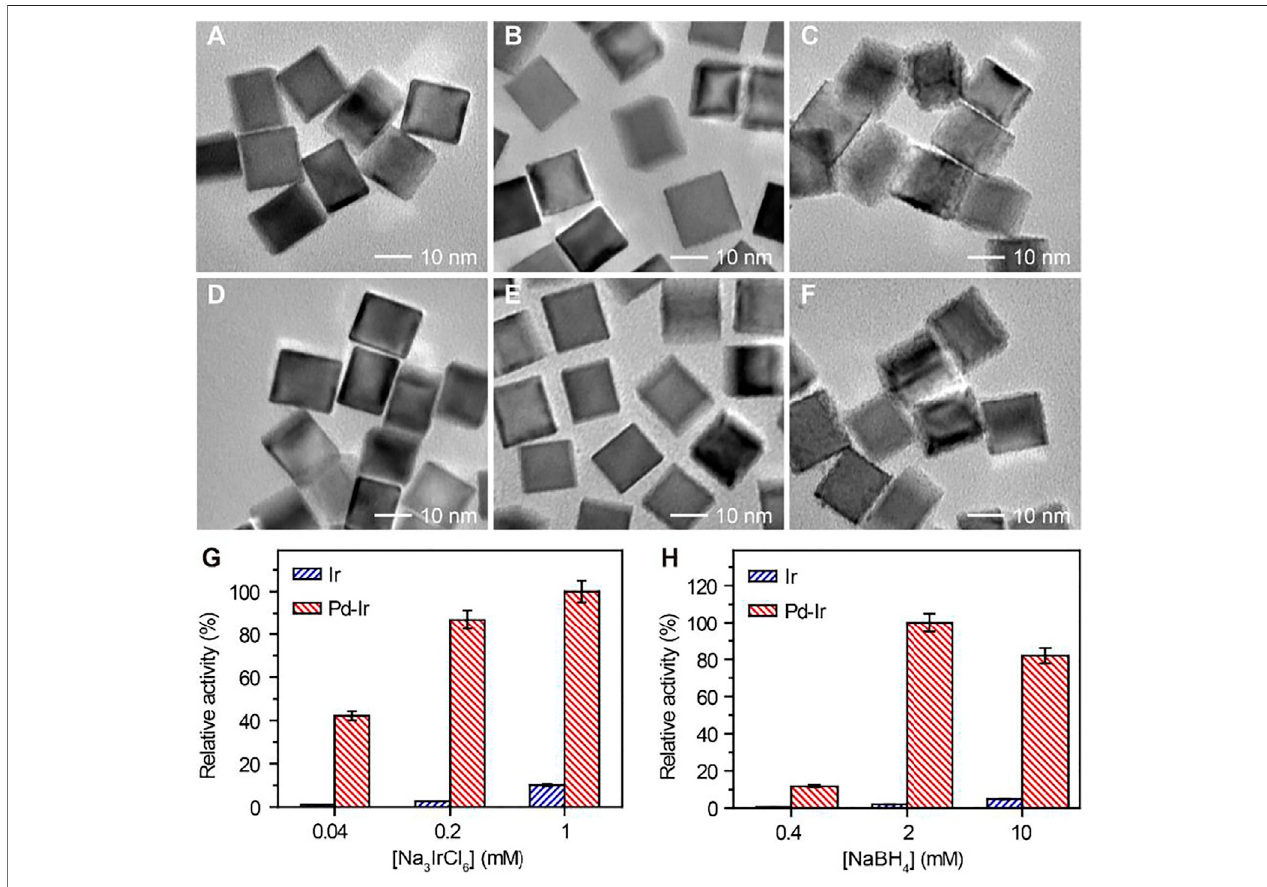
FIGURE 2 | TEM images of Pd-Ir nanocubes synthesized using (A) 0.04, (B) 0.2, and (C) 1 mM Na 3 IrCl 6 with 2 mM NaBH 4 . TEM images of Pd-Ir nanocubes synthesized using (D) 0.4, (E) 2, and (F) 10 mM NaBH 4 with 0.2 mM Na 3 IrCl 6 . Relative peroxidase mimicking activities of Pd-Ir nanocubes synthesized with different concentrations of (G) Na 3 IrCl 6 and (H) NaBH 4